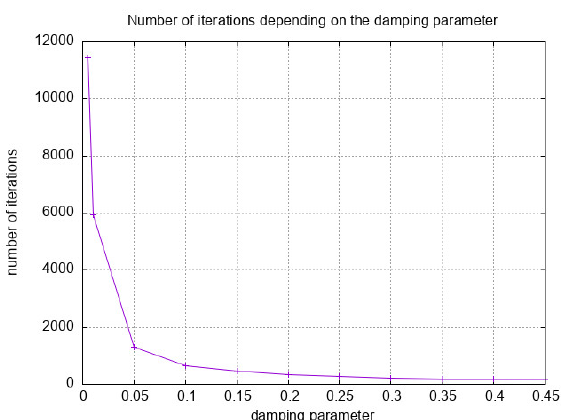
Figure 2. Number of iterations depending on the damping